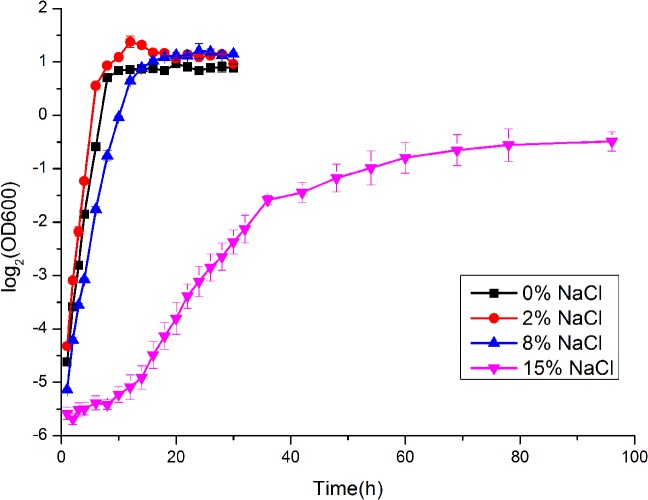
Growth curves for Bacillus sp. N16-5 grown in modified alkaline Horikoshi-II medium.
Bacillus sp. N16-5 cells were cultured in modified alkaline Horikoshi-II medium containing 0%, 2%, 8%, or 15% (w/v) NaCl.